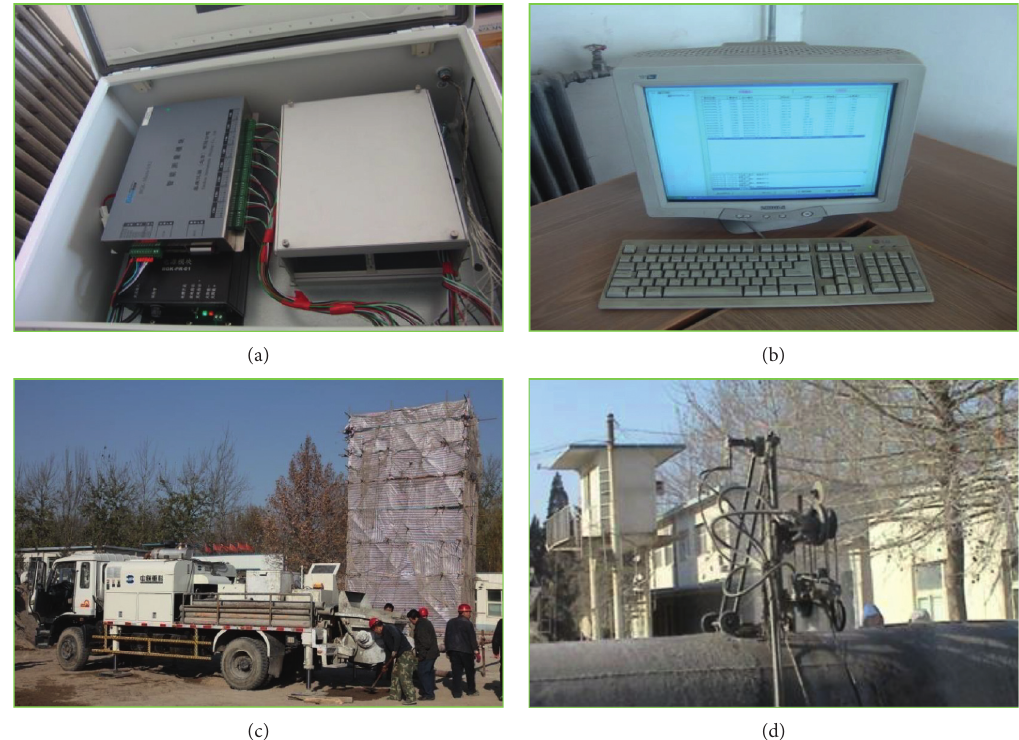
Figure 5: Test equipment. (a) Data collection instrument for vibrating-wire sensor. (b) Data collection computer. (c) Concrete pump truck. (d) Wire saw for